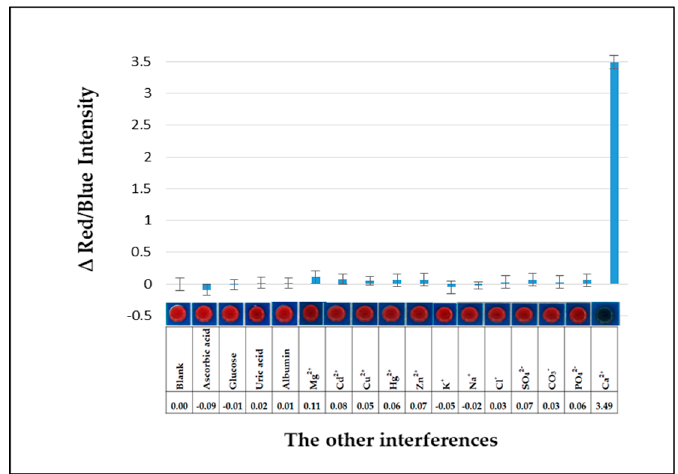
Figure 5. Responses of AHMP-AuNPs in other interferences. The concentration of Ca 2+ was fixed at 100 ppm while other interferences were used at 1000 ppm. All results were repeated three times ( n = 3). Other conditions were the same as the optimal values.